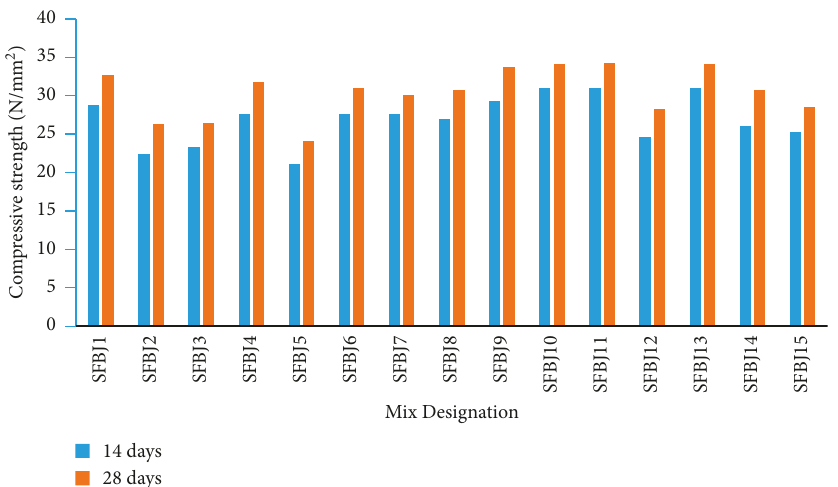
Figure 2: Concrete compressive strength with jute fibres, bamboo fibres, and silica fumes.